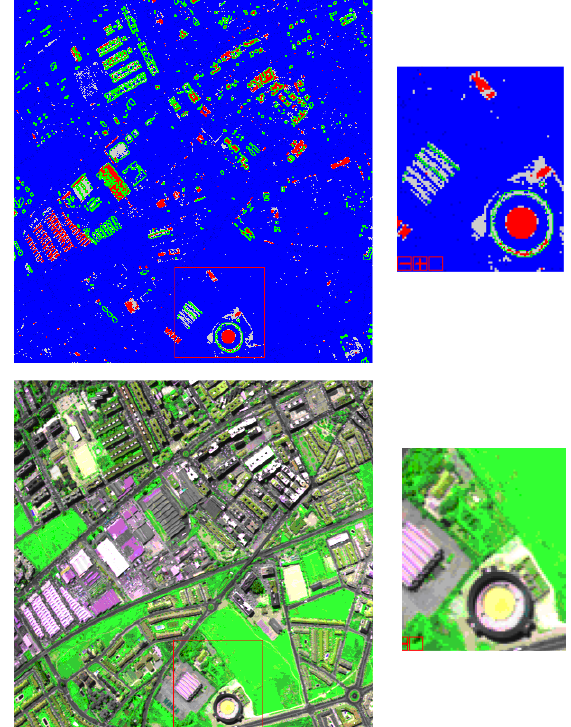
Figure 2. OSPRX anomalies in red colour (thermal anomalies in green colour not detected in VNIR) from VNIR channels of AHS (up) and AHS rgb 6,12,2 combination (down) of the Alcalá de Henares test